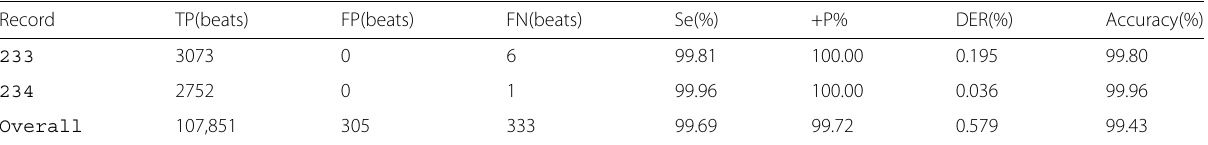
Table 2 Performance evaluation of the proposed R-wave detection method with the MIT-BIH arrhythmia database ( Continued )